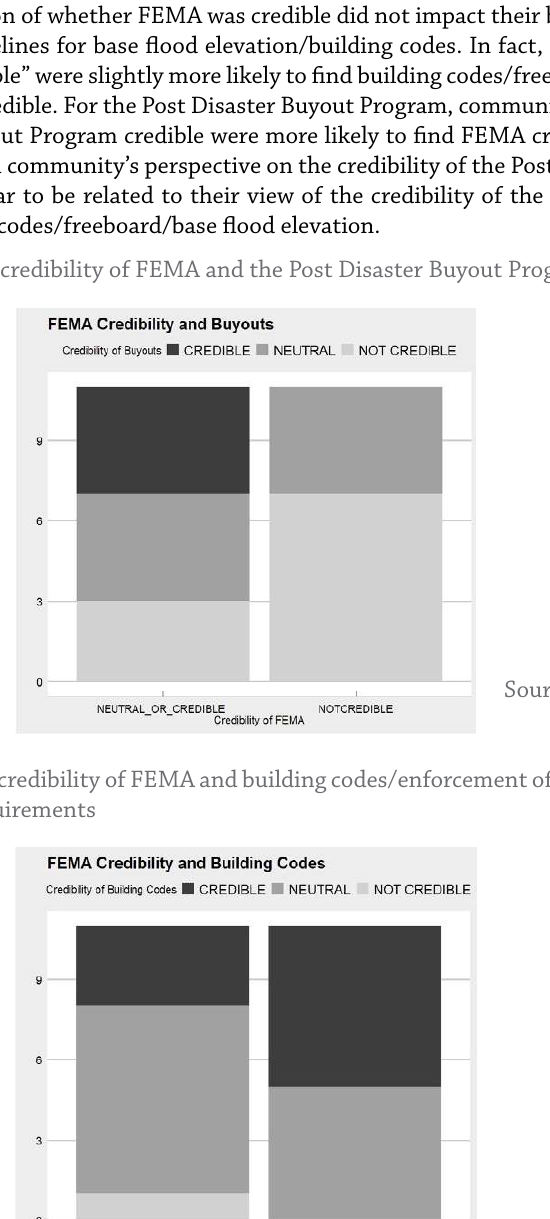
Figure 1: Perceived credibility of FEMA and the Post Disaster Buyout Program